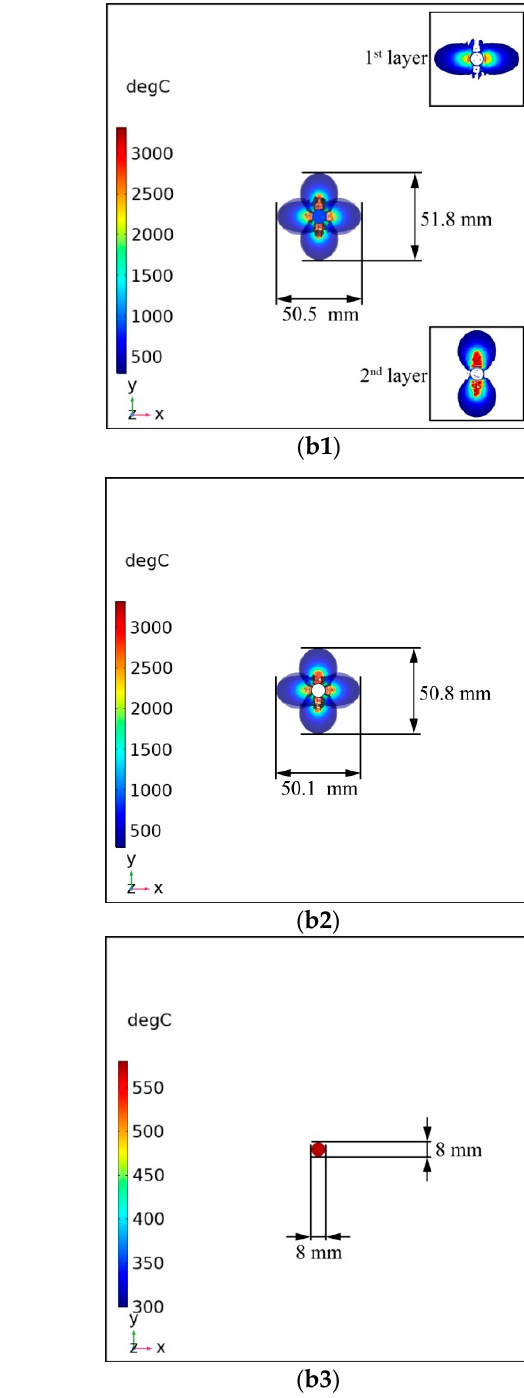
Figure 8. Temperature profiles of specimens under different simulation models and different lightning current components: component C in the ( a1 ) conduction current + heat flux model, ( a2 ) conduction current model, and ( a3 ) heat flux model; component D in the ( b1 ) conduction current + heat flux model, ( b2 ) conduction current model, and ( b3 ) heat flux model.